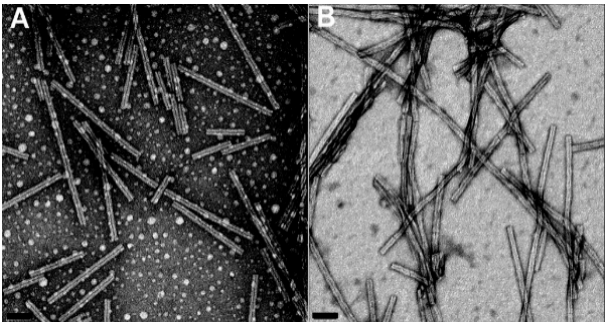
Figure 2. Negatively stained images of the protein dsGB1—an amyloid-forming mutant of the immuno-globulin binding domain of streptococcal protein G used as a model for protein folding and stability studies. Circular assemblies as well as fibrils are visible on A , and mature dsGB1 fibrils having a homogeneous and periodically twisted morphology are seen on B . Transmission electron microscopy (TEM), scale bar 50 nm. Modified from [20].